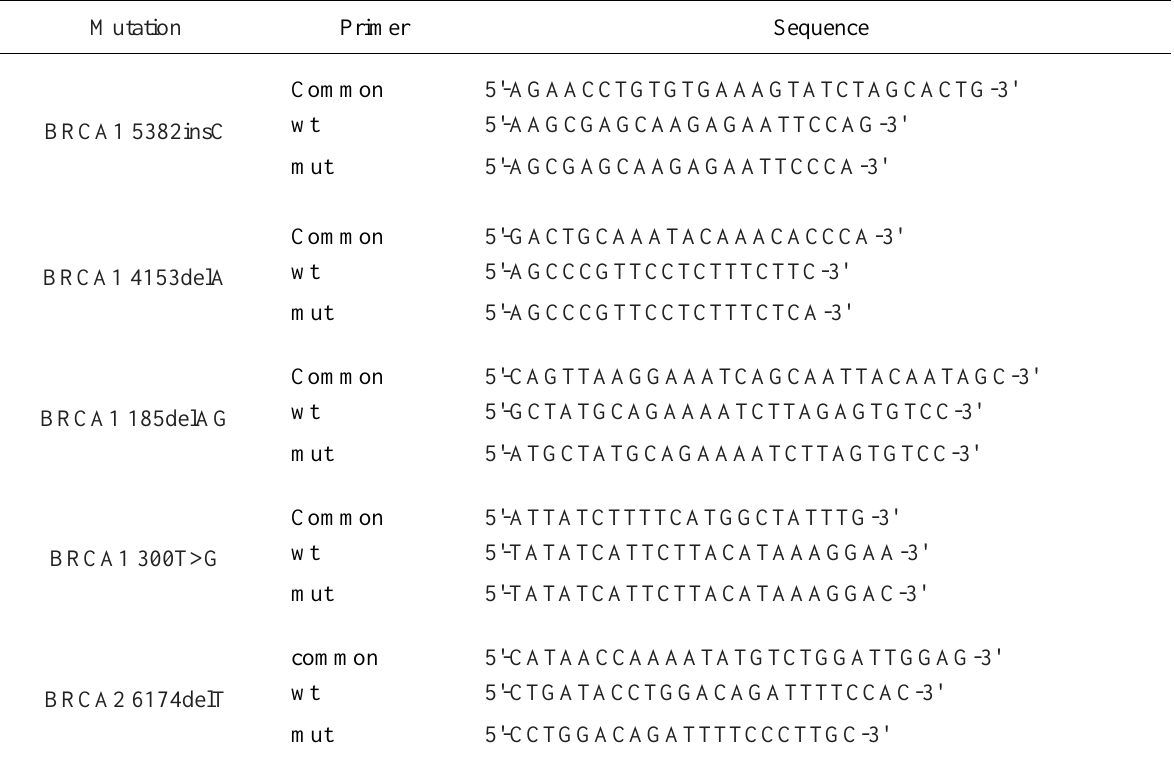
Table 1.Oligonucleotide primers used in the study